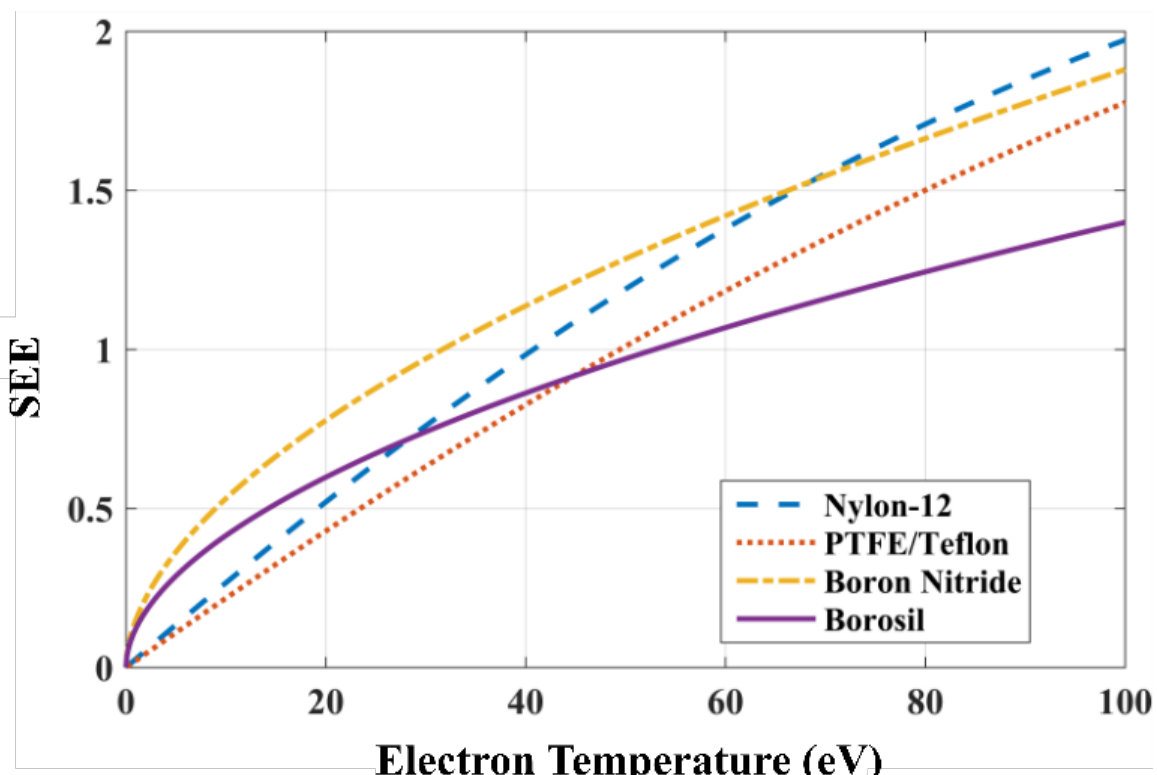
Figure 3. Extrapolated secondary electron emission as a function of temperatures for selected polymers below 100 eV.